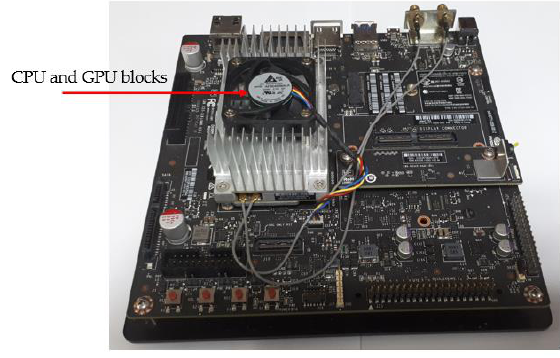
Table 12. Processing time of proposed method on a desktop general purpose computer and a Jetson TX2 embedded system (unit: ms).